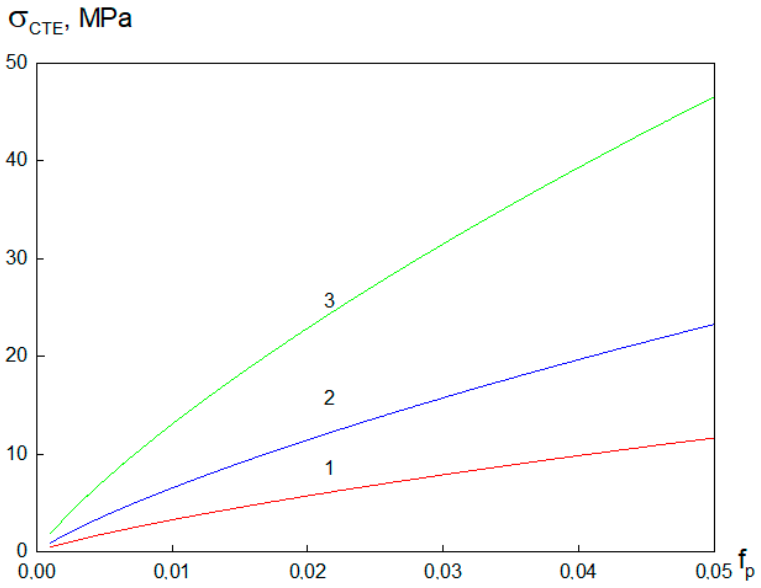
Figure 10. Dependence of thermal stresses σ CTE in the A356 alloy hardened by ScF 3 particles on the volume fraction of hardening particles, calculated for various values of ∆ T . Particle size δ p = 80